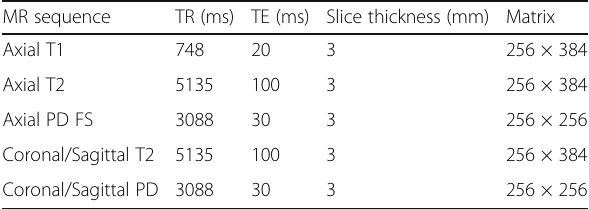
Table 2 3T MRI protocol Used In The Study With A 10% gap and FOV not more than 150 – 160 cm MR sequence